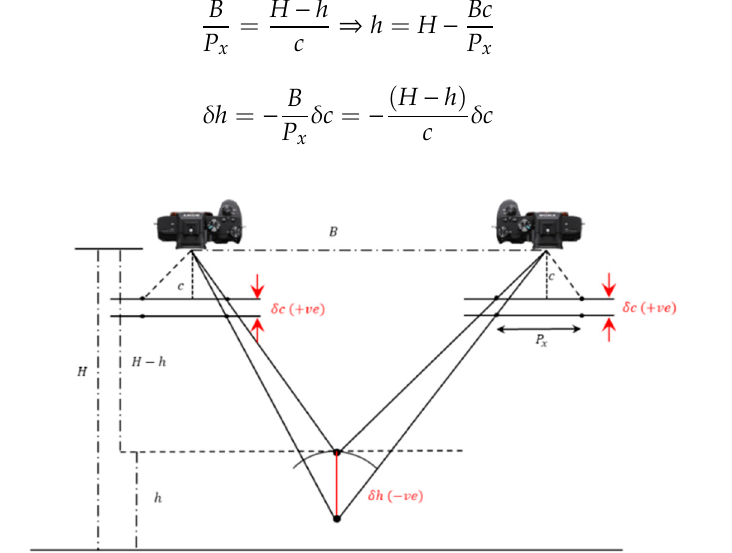
Figure 6. Impact of a bias in the principal distance ( 𝛿𝑐 ) on object point coordinates.